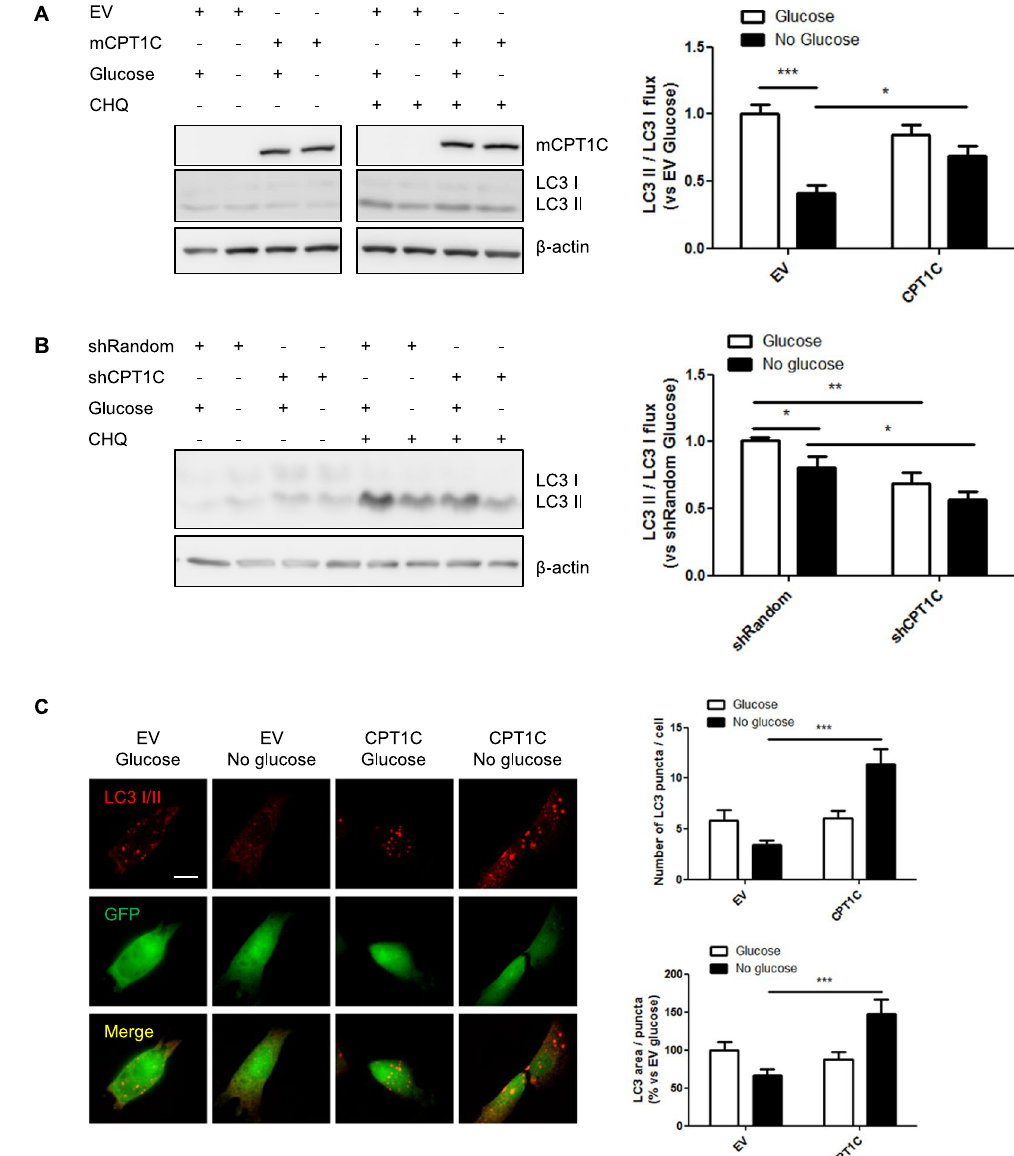
Figure 4. CPT1C overexpression promotes autophagy under glucose-depleted conditions. ( A , B ) Quantification of the LC3II/LC3I flux in EV and CPT1C-hMSCs ( A ) or shRandom and shCPT1C-hMSCs (B) in the presence or the absence (24 h) of glucose. In some of the wells, 50 µ M chloroquine was added 1 h before cell recollection. LC3 I and LC3 II were analyzed by Western Blot. GFP was used as a transduction control and β -actin as a loading control. Blots displayed in A were cropped from different parts of the same gel (see full-length blot in Supplemental Fig. 6A). Results are shown as mean ± SEM of 3 independent experiments performed in duplicate. ( C ) LC3 was detected by immunocytochemistry in EV- or CPT1C-hMSCs 24 h after glucose depletion. Twenty randomly selected cells per condition were analyzed in 5 independent experiments performed in duplicate. The graphs show the number of LC3 puncta per cell (above) and the LC3 area per puncta (down) and are expressed as mean ± SEM. Scale bar 20 µ m. * p < 0.05; *** p <